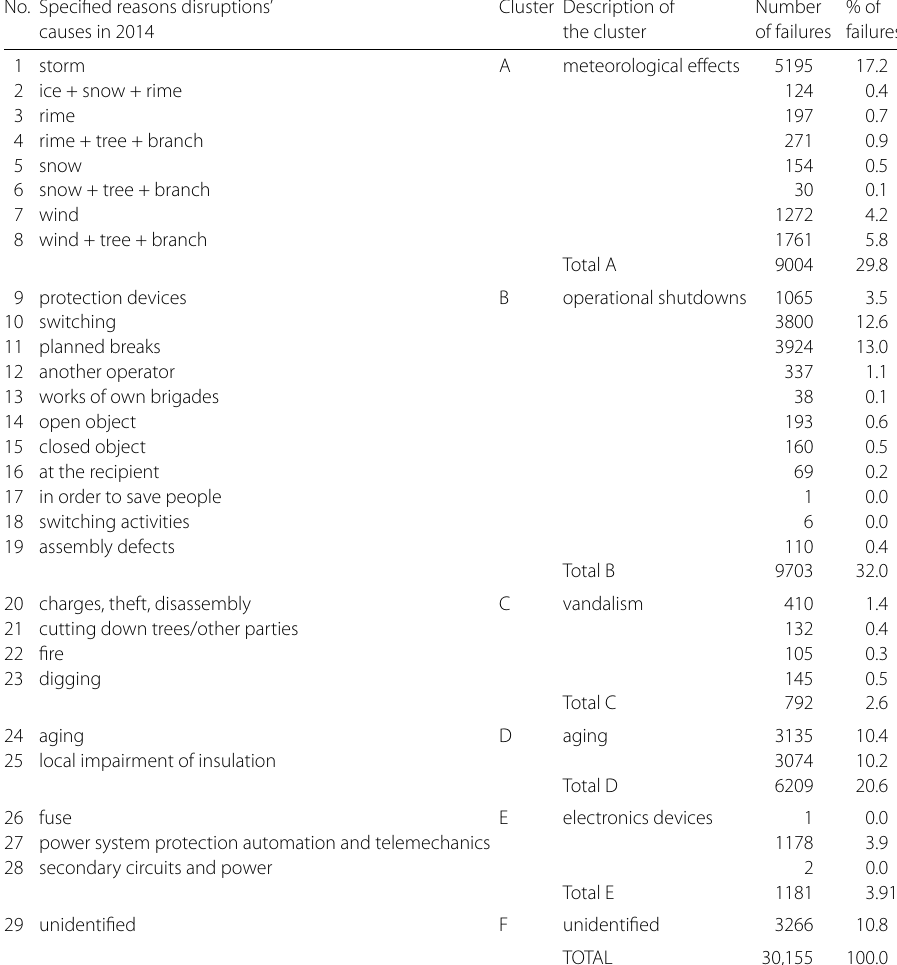
Table 3 Electrical grids disruptions’ causes in southern Poland distribution network in January–July 2014 No. Specified reasons disruptions’ causes in 2014